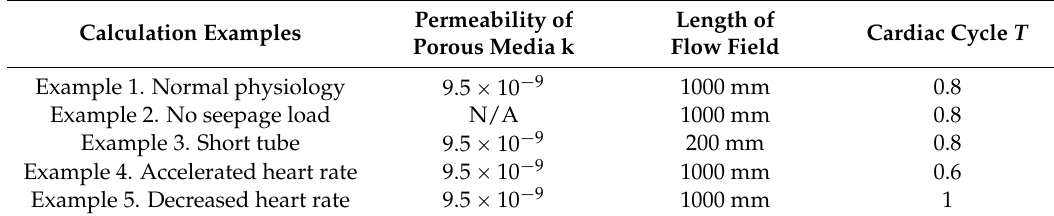
Table 1. Five calculation examples and their parameters.